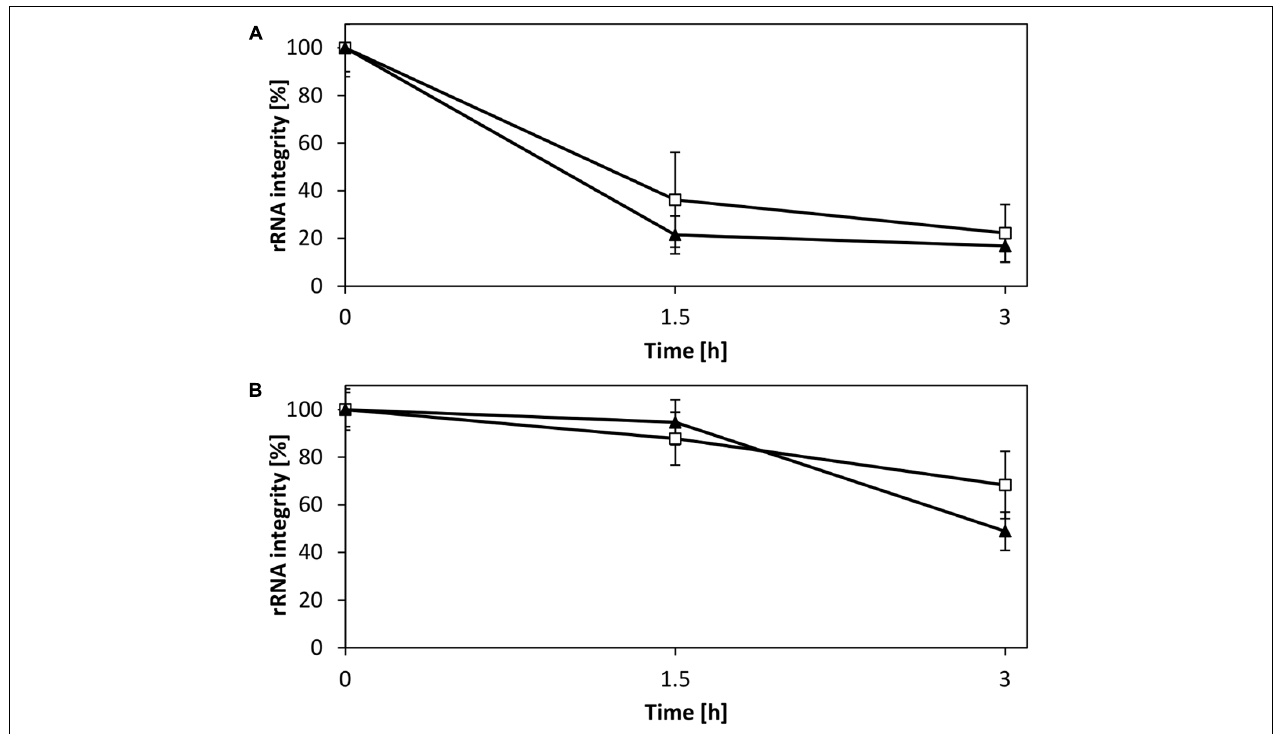
FIGURE 6 | Stability of rRNA in CFPS reactions. Shown is the integrity of the 16S rRNA ( (cid:3) ) and 23S rRNA ( (cid:72) ). (A) CFPS fueled with creatine phosphate, which results in the accumulation of phosphate and magnesium sequestration. (B) CFPS fueled with pyruvate allows for magnesium homeostasis and demonstrates elevated rRNA stability. Error bars represent standard deviations of triplicate